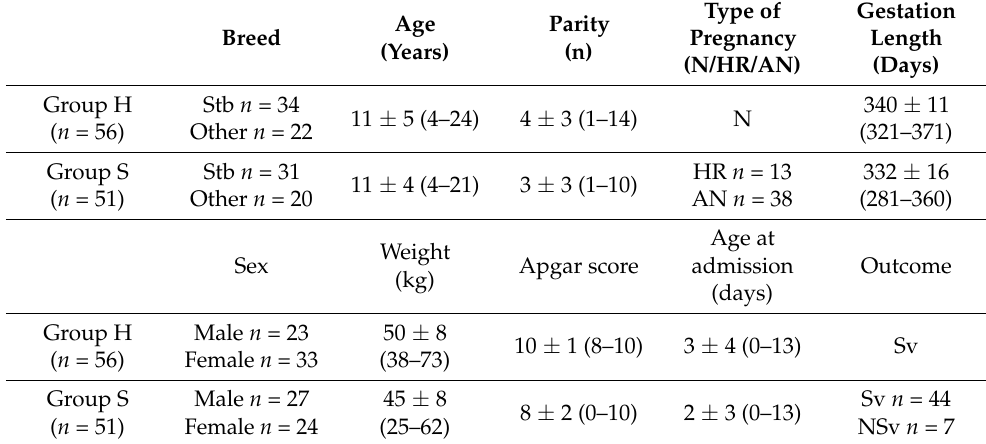
Table 1. Study 1, clinical data collected for mares and foals of the two groups (Heathy—H and Sick—S). Data are expressed as mean ± standard deviation (min-max). Stb =